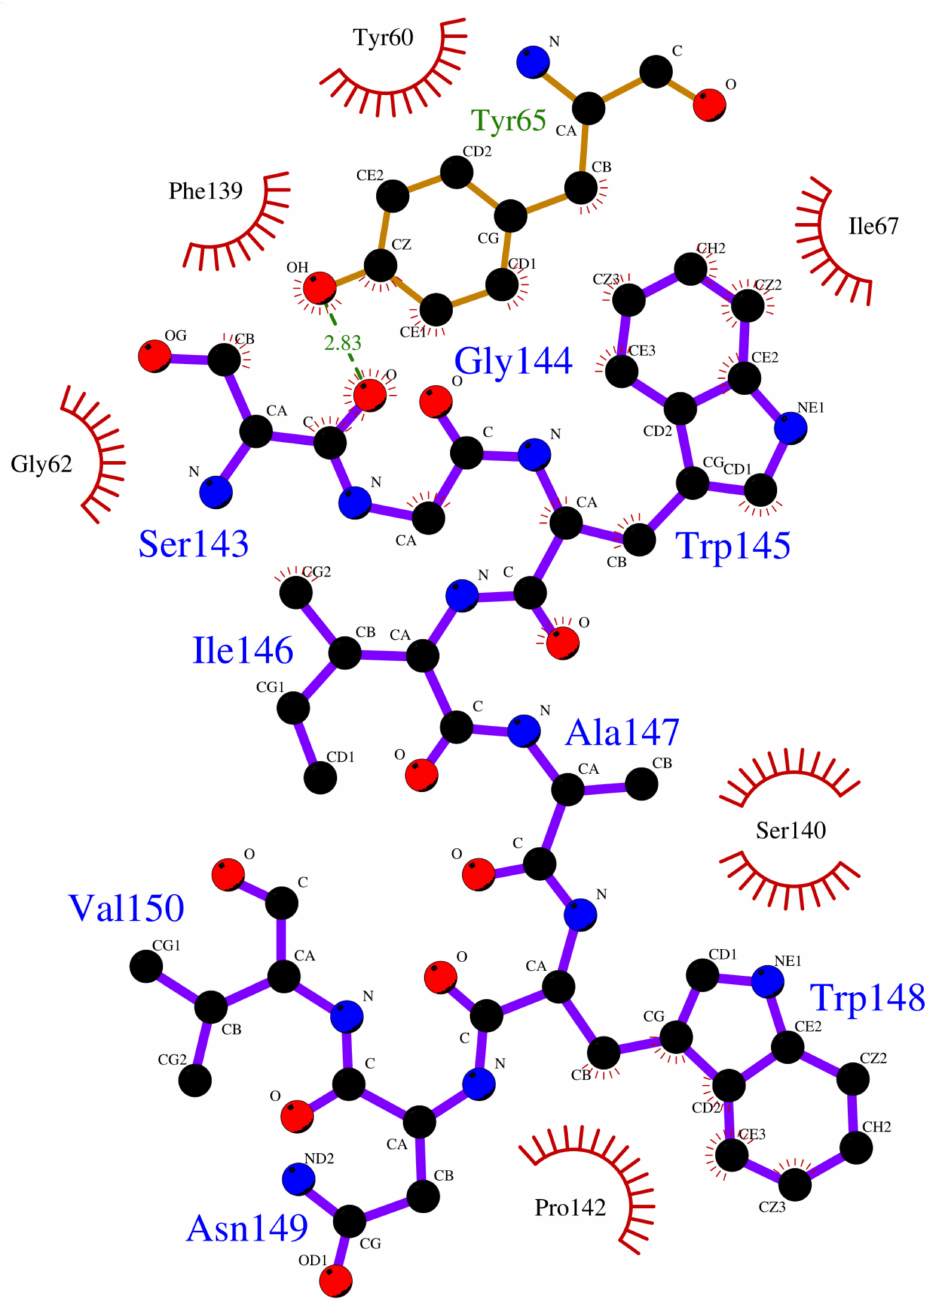
Figure 6. Overview of binding modes of the UEV domain proteins with